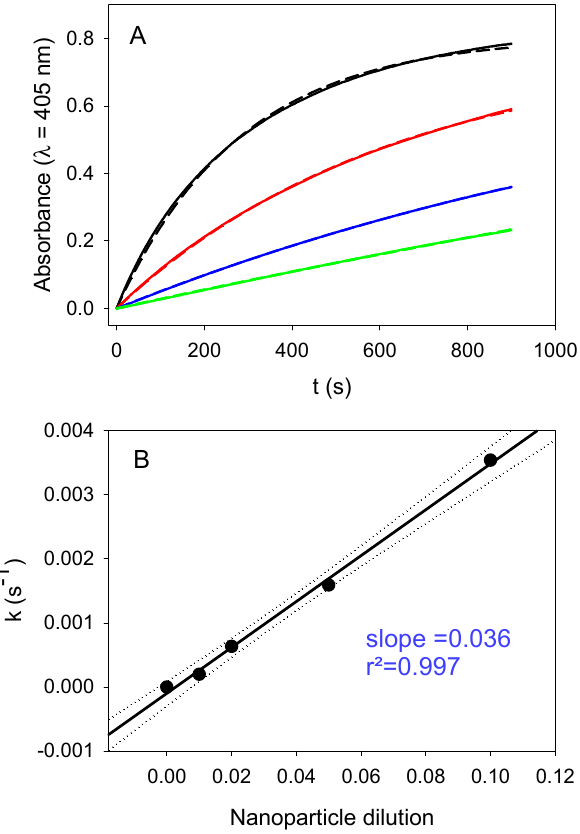
Figure 7. Influence of the dilution of PDA@ALP nanoparticles on their enzymatic activity. ( A ) Hydrolysis of 10-fold diluted PNP solutions in the presence of PDA@ALP nanoparticles at different